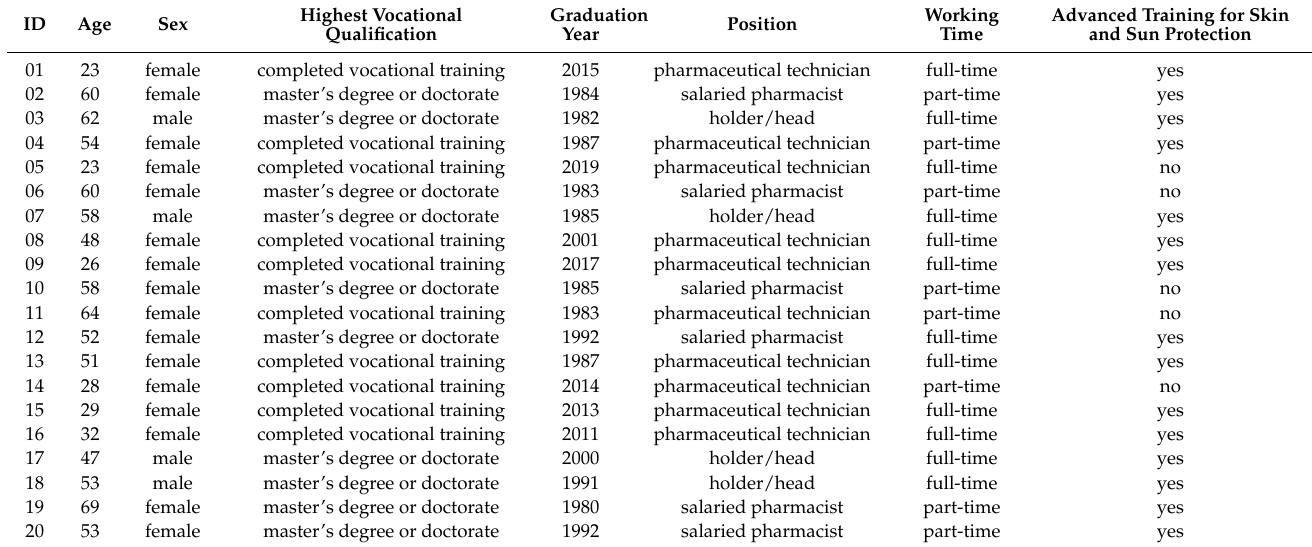
Table 1. Characteristics of 20 pharmacists and pharmaceutical technicians participating in qualitative interviews.